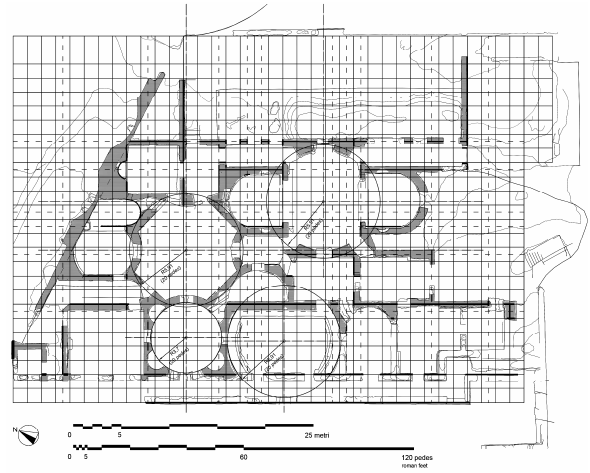
Figure 5. A hypothesis on the modular grid of Small Baths.